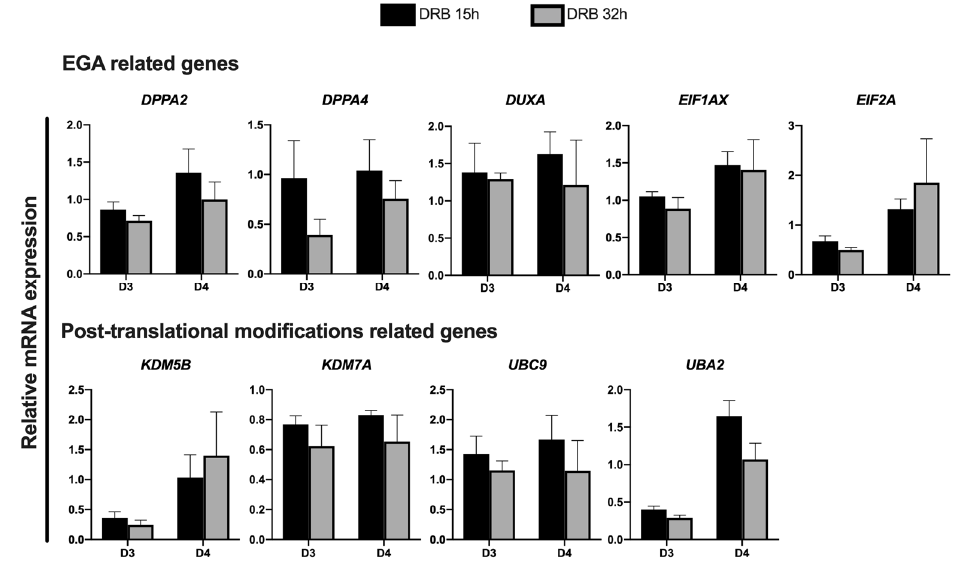
Figure 5. Relative abundance of transcripts in SCNT embryos on days 3 and 4 of development that were treated with Scriptaid for 15 h + DRB for 15 h (DRB 15 h) or 32 h (DRB 32 h) after nuclear transfer. A total number of 10 to 15 embryos were collected per replicate (n = 3) and treatment for each day of development. No statistical difference was observed between treatments at both days of development. of